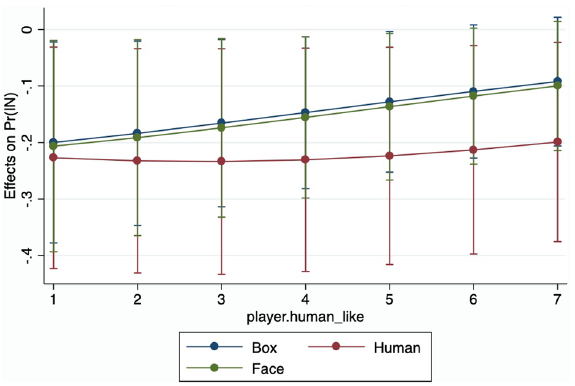
Figure 3. Marginal effect of Sympamp High on the probability of playing